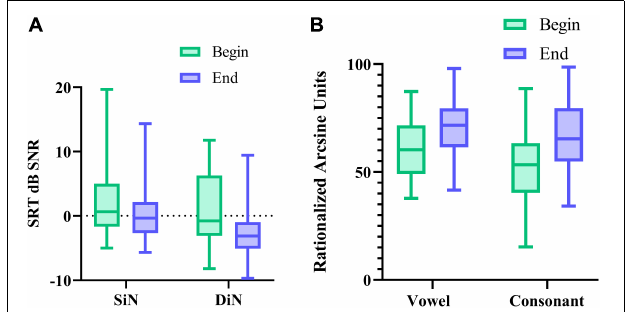
FIGURE 5 | (A) median SRT in noise (and IQR) for SiN, DiN, and (B) median percentage vowel and consonant identification in quiet (and IQR) at the beginning and end of the 16-week trial.